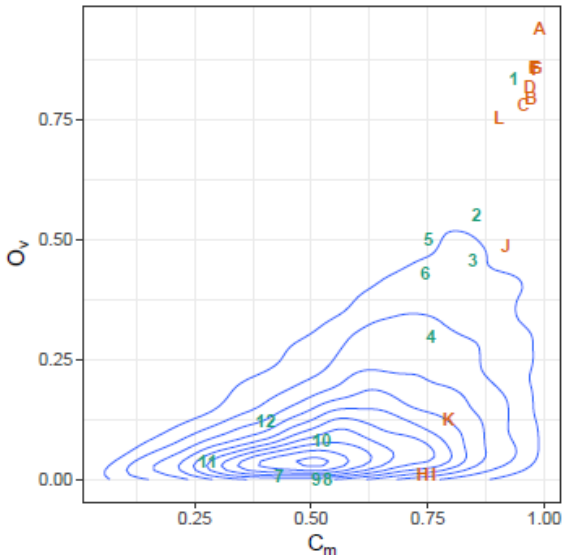
Figure 11. Observed similarities in the HEV clinical case plotted over the 2D-density of the simulated data. Similarities in haplotype distribution between pairs of sequential samples are labeled with numbers in increasing order, similarities in phenotype distribution are labeled with alphabetically ordered capital letters. The points on the top-right show high similarity by both